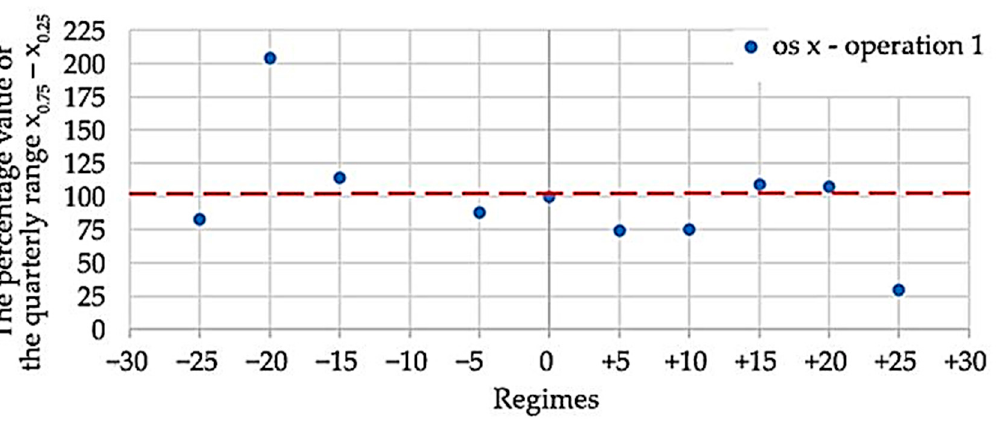
Figure 13. The percentage value of the quarterly range x 0.75 – x 0.25 .